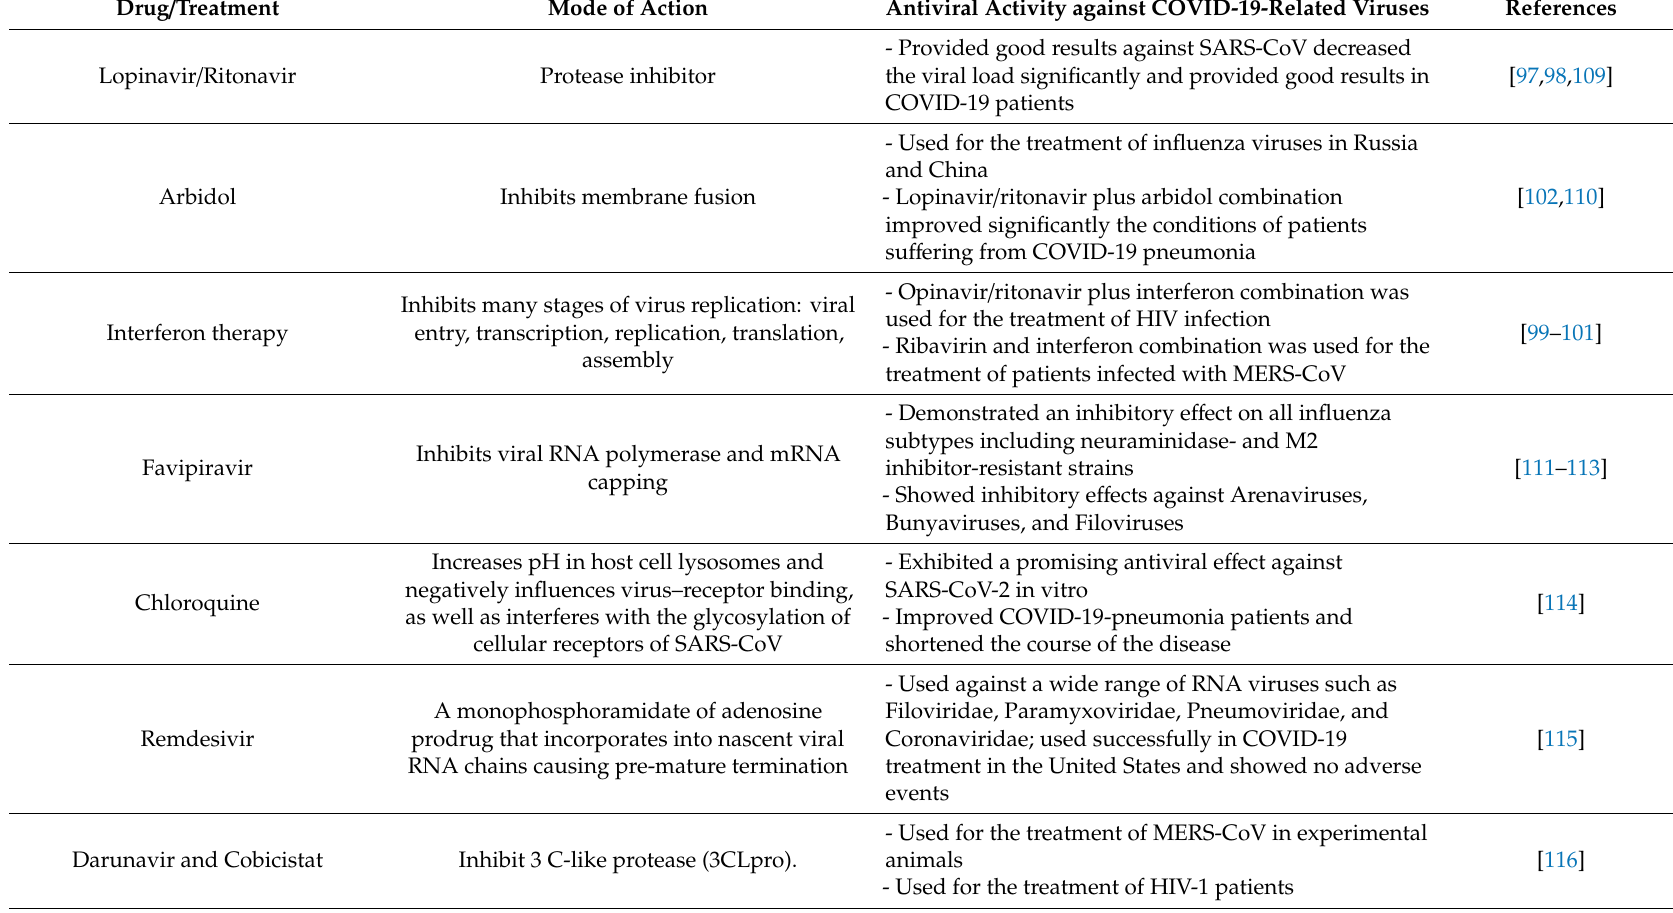
Table 5. Summary of drugs / treatments registered for clinical trials against